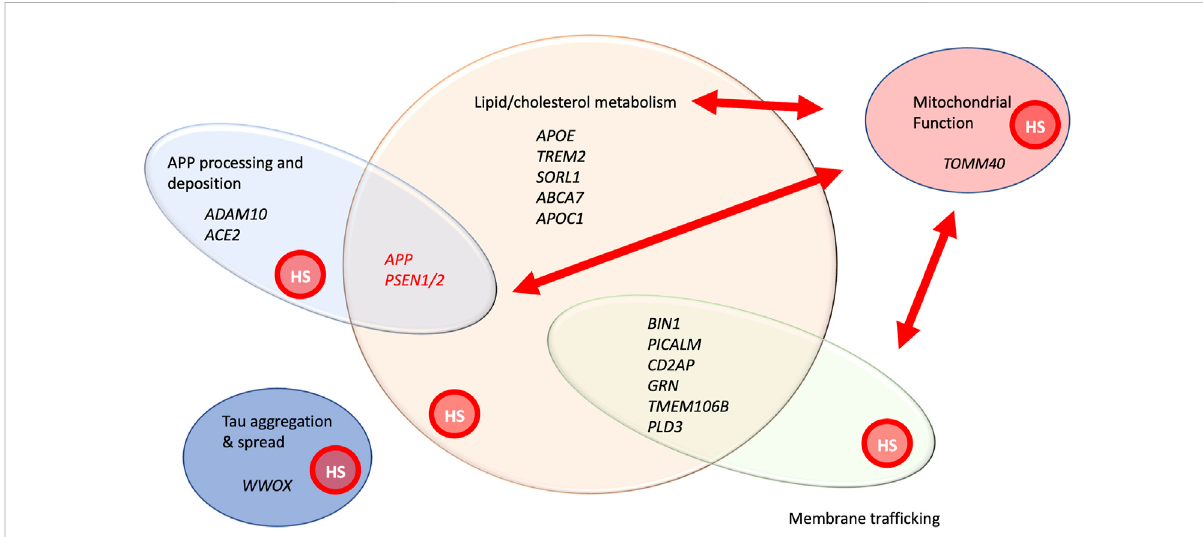
FIGURE 2 AfunctionalsnapshotofADgeneticsandcellularprocessesimplicatedbygenesinvolvedinearlyonset,familialAD,aswellgenesimplicatedby GWAS analysis oflate onset AD (Scheltenset al.,2021; Bellenguez et al., 2022).Genes inblack print have been identi fi edby either sequencingof rare variants or GWAS analysis. APP and PSEN1/2 are shown in red print to highlight both their high penetrance in affecting AD and their association with early onset AD in families. Some of the genes with variants showing signi fi cant association with AD from GWAS are listed, representing functionalcategories.Thisisnotintendedtobeacomprehensivelist,butsimplyprovidingillustrativeexamplesofgeneswithinthesegroupings.Red arrows represent the important functional relationships between cellular processes and genes affecting them, with mitochondrial activity. The graphicoverlayofgroupsrepresentsthatthesearefunctionallyconnectedgroupsandgenescanparticipateinmorethanoneoftheseprocesses. All these processes are known to be affected by HSPGs, denoted by the red circle labelled, “ HS ” within each functional group. References providing evidence for HSPG involvement in these processes include the following: APP processing and deposition (Snow et al., 1988; Jendresen et al., 2015; Liu et al., 2016), lipid/cholesterol metabolism (Yamashita et al., 2018), mitochondrial morphology and function (Reynolds-Peterson et al., 2017; Yamashita et al., 2018; Schultheis et al., 2021), membrane traf fi cking (Shteingauz et al., 2015; Reynolds-Peterson et al., 2017; Sanderson et al., 2017; Nadanaka and Kitagawa, 2018; Reynolds-Peterson et al., 2020) and Tau aggregation and